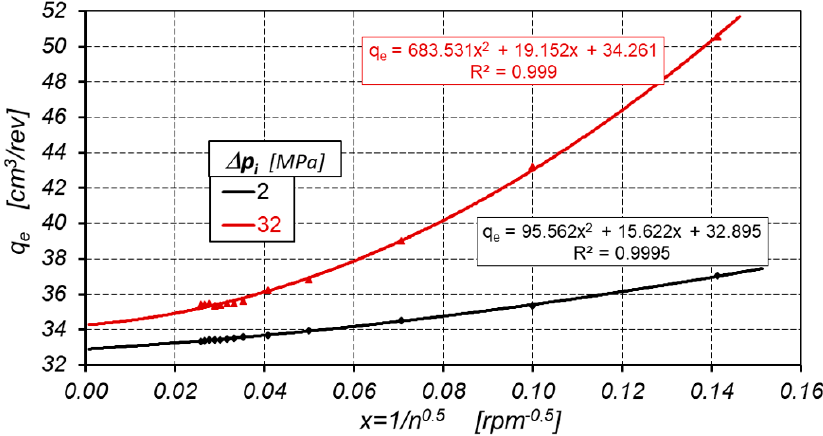
Figure 15. Characteristics q e = f(n − 0.5 ) at Δ p = const .—according to the new method.